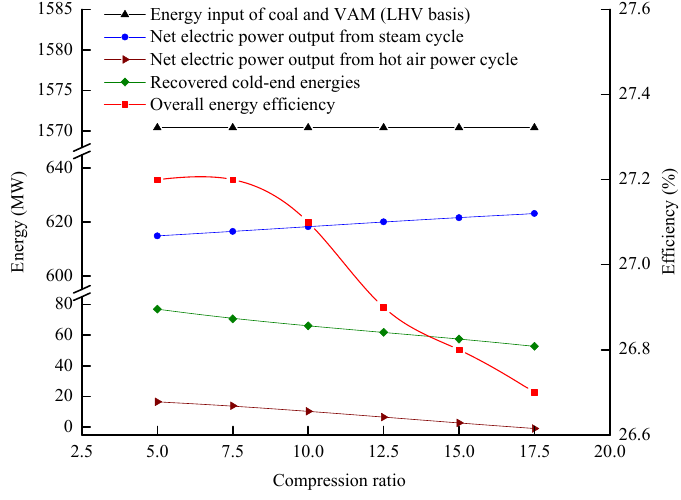
Figure 8. Influence of the compressed VAM pressure on the overall system performance.